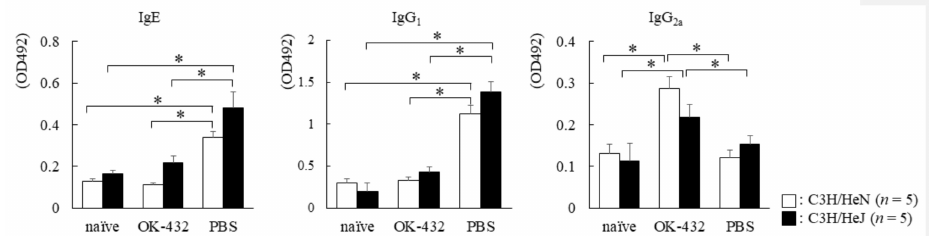
Figure 3. Serum levels of OVA-specific Igs in C3H/HeN (white bars) or C3H/HeJ (black bars) mice sensitized with OVA. Individual levels of OVA-specific Igs were determined by an ELISA in C3H/HeN or C3H/HeJ mice on day 14 after i.p. injections with OVA/ALUM on day 0 and day 7, or naive C3H/HeN or C3H/HeJ mice without sensitization of OVA. PBS-treated mice were intraperitoneal (i.p.) injected with PBS on day 0 and day 7. OK-432-treated mice were i.p. injected with 100 mg OK-432 on day 0 and day 7. Data were obtained from three independent experiments and are expressed as the mean of triplicate determinations ± SD. Per experimental group, five mice were used. *, p < 0.005. In response to OVA, splenic CD3 + T cells of PBS-treated C3H/HeN and C3H/HeJ mice sensitized with OVA actually produced IL-4, whereas IL-4 production significantly decreased in OK-432-treated C3H/HeN and C3H/HeJ mice sensitized with OVA (Figure 4). Furthermore, IFN- γ production in response to OVA increased in the culture supernatants of splenic T cells from OK-432-treated C3H/HeN and C3H/HeJ mice sensitized with OVA.